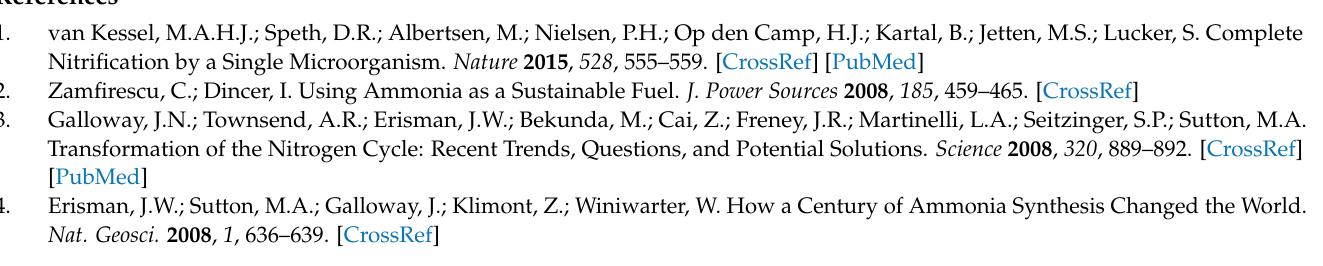
3 N 4 . (Label * denotes the status of